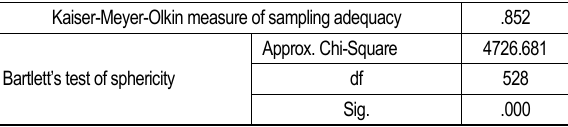
Table 5. KMO and Bartlett’s test